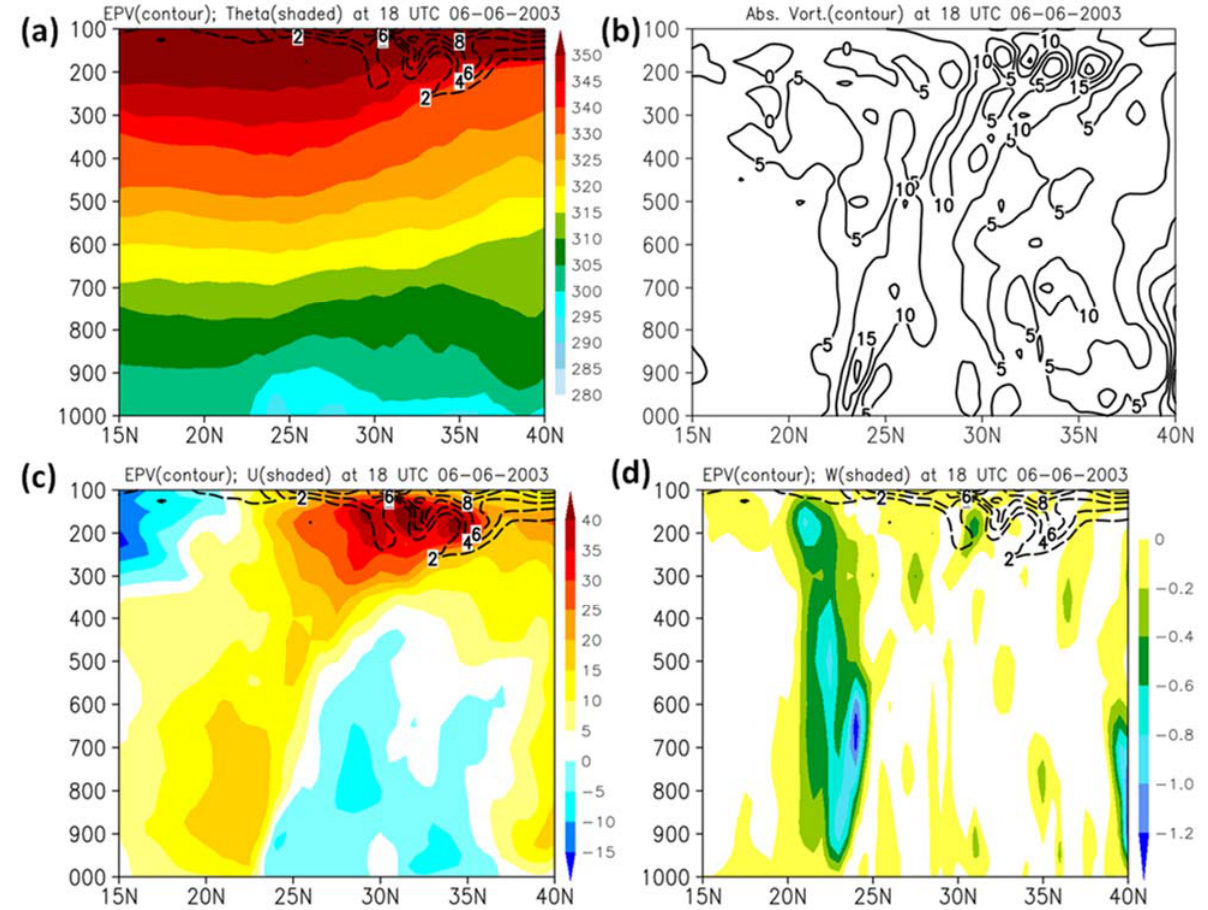
Figure 8. The CFSR latitude–height cross-sections along 117 ◦ E. ( a ) Ertel’s potential vorticity (PVU, dashed lines) and potential temperature (K, black contours); ( b ) absolute vorticity (10 − 5 s − 1 , con- toured); ( c ) EPV (PVU, dashed lines) and zonal winds ( u ) (m s − 1 , shaded); and ( d ) EPV (PVU, dashed lines) and vertical velocity (Pa s − 1 , shaded) at 1800 UTC 6 June (0200 LT 7 June) 2003. PVU = 10 − 6 m 2 K kg − 1 s − 1.